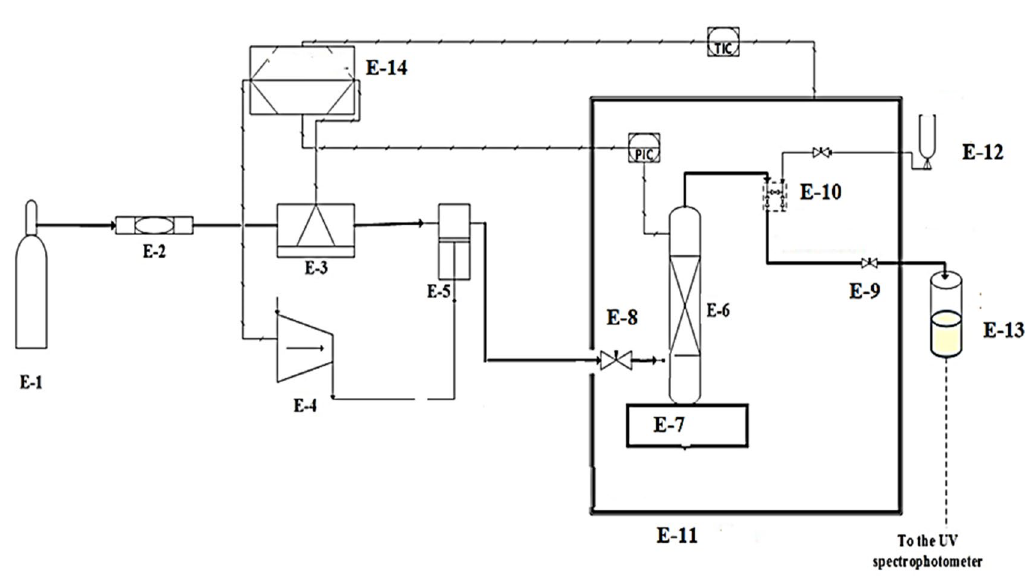
Figure 1. Device used for the measurement of solubility, E1 is the CO 2 cylinder; E-2 is the Filter; E-3 is the Refrigerator unit; E-4 is the Air compressor; E-5 is the Pump; E-6 is the Equilibrium cell; E-7 is the Magnetic stirrer; E-8 is the Needle valve; E-9 is the Back-pressure valve; E-10is the Six-port valve; E-11 is the Oven; E-12 is the Syringe; E13 is the Collection vial; E-14 is the Control